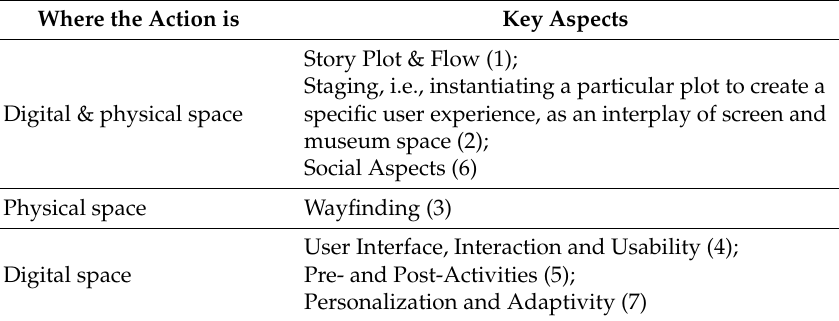
Table 2. Classification of key aspects